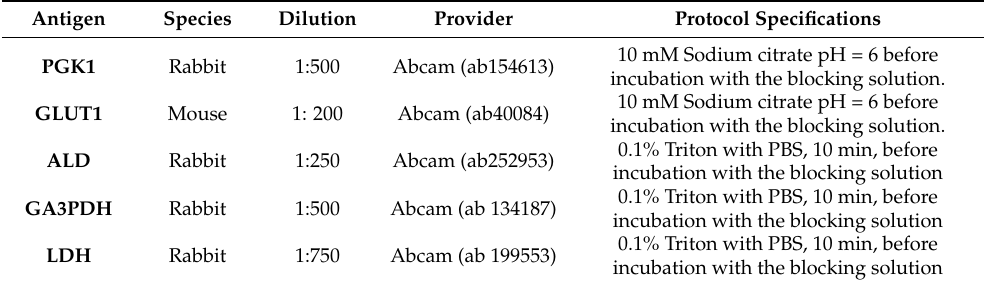
Table 2. Different antibodies (A. primary, B. secondary) used in the immunohistochemistry studies performed, with dilutions and protocol features. The data for all the experiments are listed in Supplementary Materials. Antigen Provider Protocol Specifications